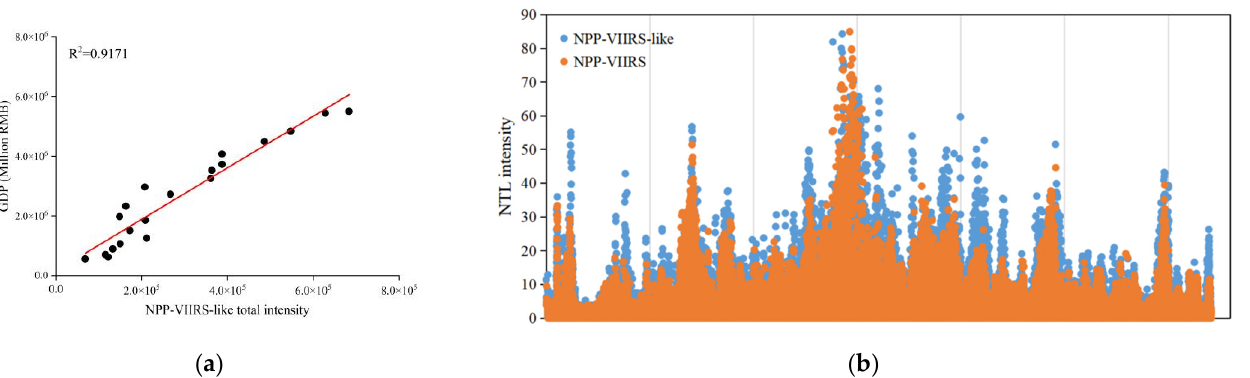
Figure 3. Evaluation of temporal consistency of the NPP-VIIRS-like NTL data in Henan Province. ( a ) Correlation between NPP-VIIRS-like NTL total intensity data and GDP data in Henan, and ( b ) variation trends of NPP-VIIRS annual synthetic NTL data and NPP-VIIRS-like NTL data sets in 2012